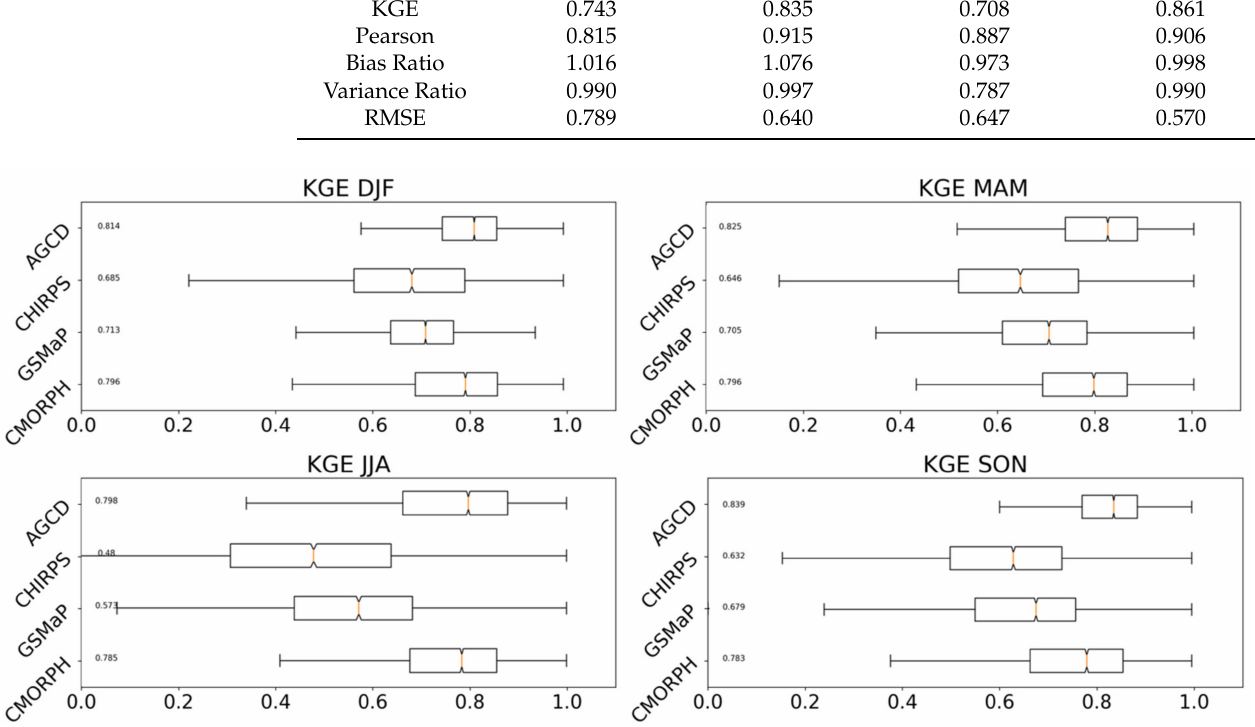
Figure 4. Boxplots showing the distribution of the Kling–Gupta efficiency (KGE) between SPEs and AGCD with MSWEP for each season. Outliers are not included within the boxplots to improve clarity. The median value (orange line) is shown on the left of each